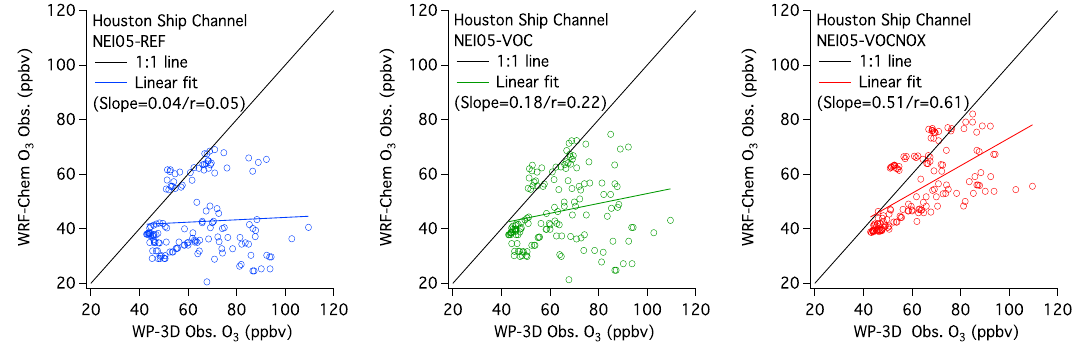
Figure 14. Scatter plots of simulated and observed O 3 data below 1km above ground level from 6 daytime WP-3D flights that are influenced by the sources in Houston Ship Channel. Houston Ship Channel flights are defined as in Fig. 9 for the same 6 daytime flights. 4 agreement with the satellite NO 2 columns for the large cities and regions with large power plants except for Houston, where the model columns are 50 %–70 % higher than the satellite columns. This study is the first in which 4 different OMI retrievals from 3 institutes are used. The 4 independent OMI NO 2 column retrievals agree within 20 % over Dallas and within 5 % over